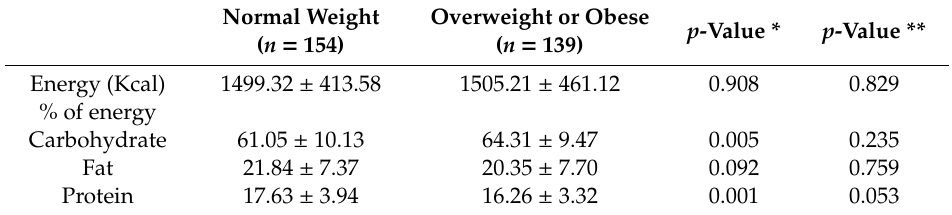
Table 3. Dietary nutrient consumption according to body mass index